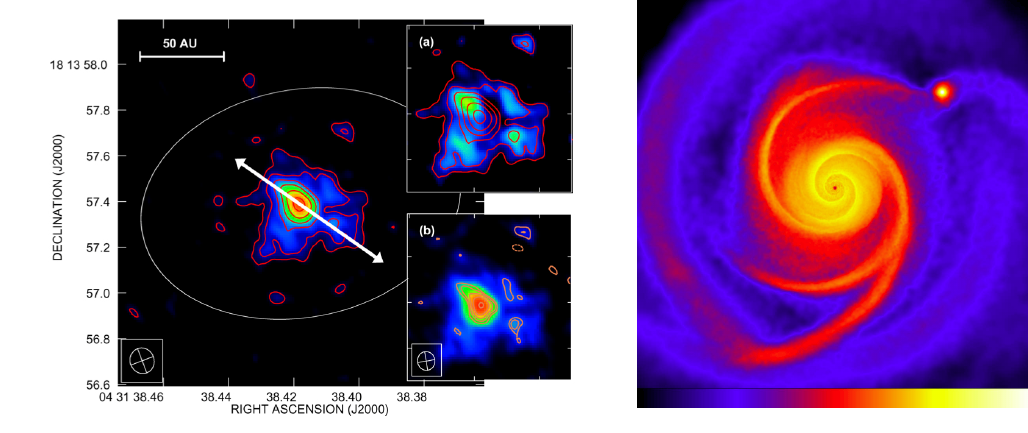
( Left ) A radio image of the HL Tau system showing excess emission at (cid:24) 65 AU (upper right quadrant of the left-hand images), which could be a protoplanet in formation. ( Right ) A simulation showing how such an object could indeed form, through direct gravitational collapse, in the outer parts of a disc like that in the HL Tau